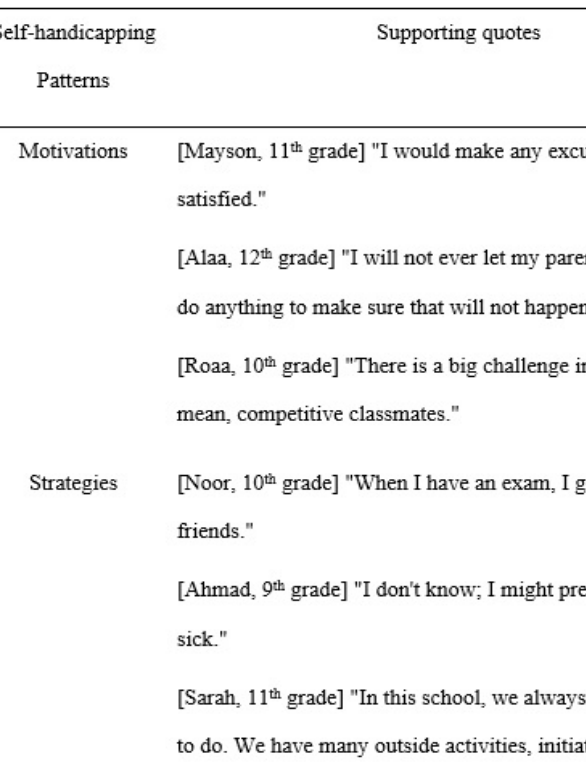
Codes and Supporting Quotes for the Self-handicapping Patterns